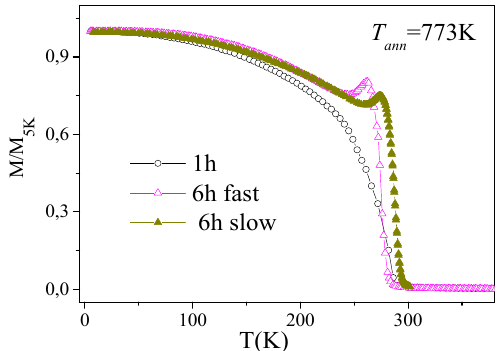
Figure 42. Temperature dependence of magnetization for NiMnGa microwires (d = 18 μ m) annealed at 773 K with different conditions. Reproduced from reference [117], Figure 4.